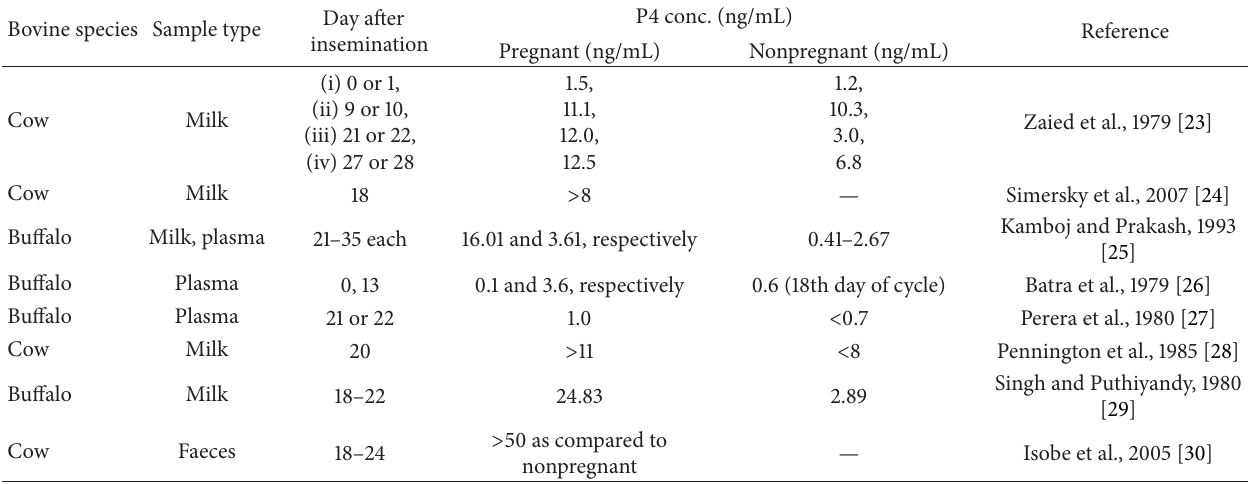
Table 2: Progesterone levels in different sample types in bovine